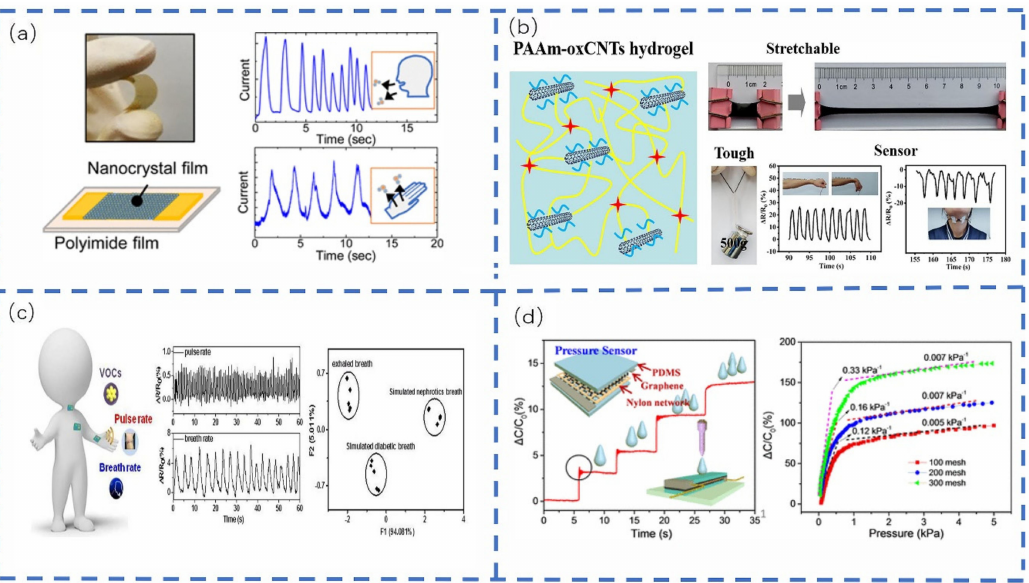
Figure 11. Flexible sensors for health monitoring: ( a ) a schematic of bent forked finger electrodes and a humidity sensor on PI film [173]; ( b ) a schematic of PAAm-oxCNTs hydrogel and images under stretching as an application for monitoring subtle human motion [174]; ( c ) a graphene film flexible sensor with different functions for simultaneous monitoring of physiological signals and biomarkers [175]; and ( d ) a schematic of a low-cost nylon mesh pressure sensor with micro-sized square holes and pressure sensing sensitivity curves for three pressure sensors, each with different mesh sizes of nylon